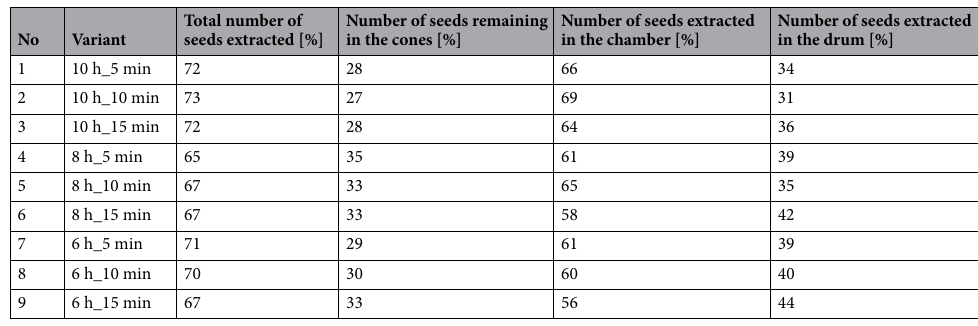
Table 7. Number of seeds extracted from and remaining in the cones for each process